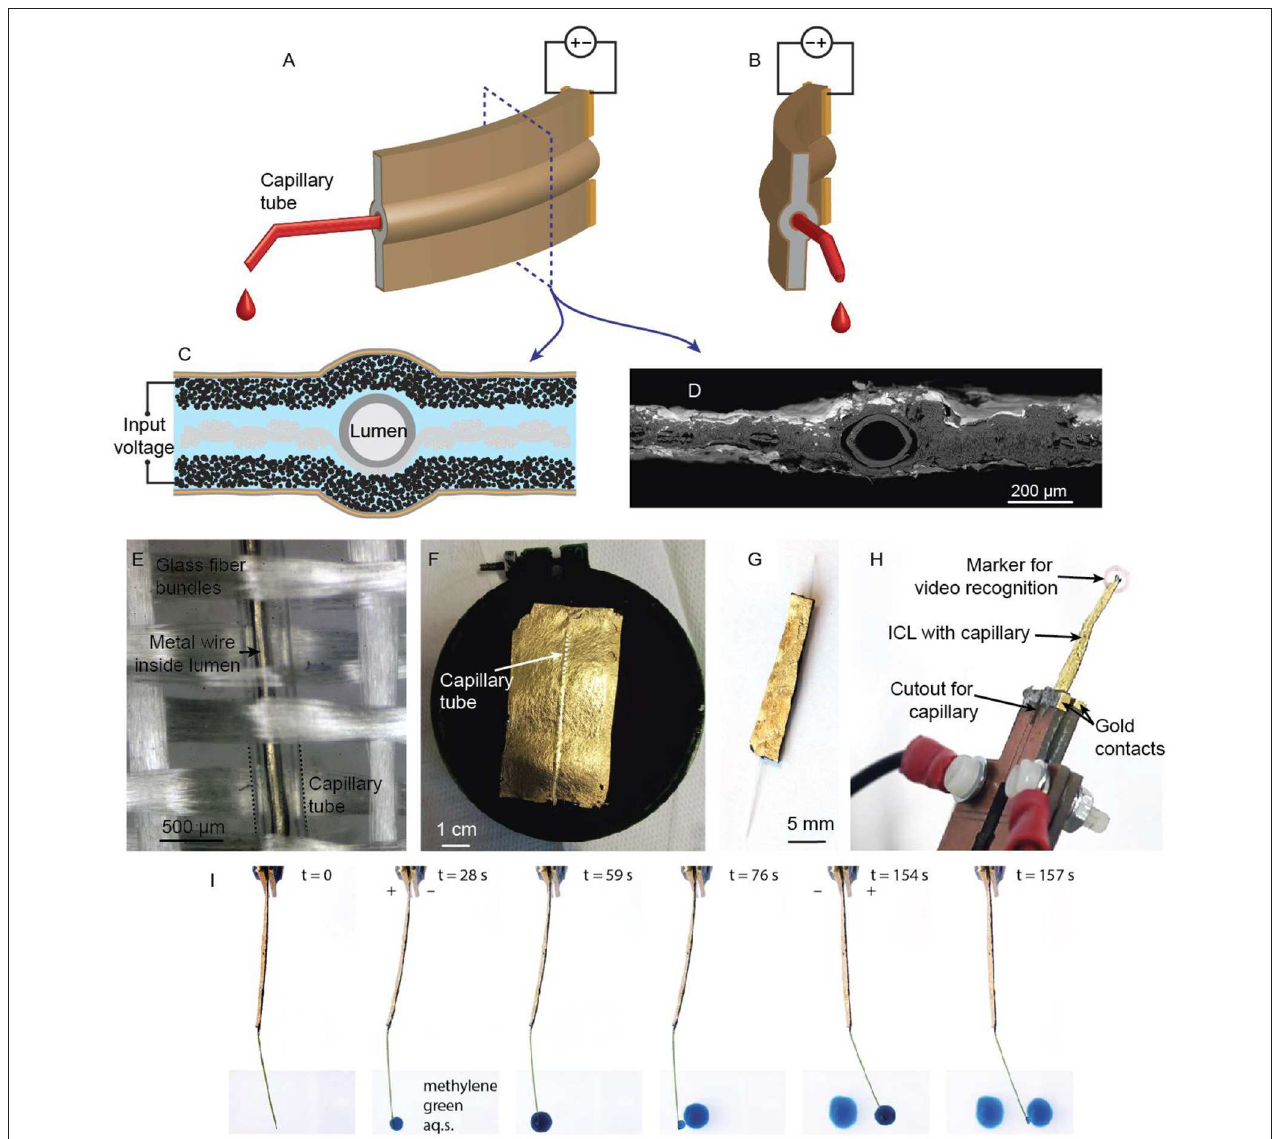
FIGURE 5 | (A,B) the concept of an active pipette for positioning fluids in oppositely polarized states. (C) The cross-section diagram and (D) an SEM micrograph of the mosquito proboscis-inspired ICL-pipette assembly, showing the arrangement of the capillary tube in the center of the laminate. (E) A macro photograph of the glass fiber cloth with an interwoven capillary tube before application of the membrane. (F) The active pipette after application of electroactive layers; the elevated strip indicates the location of the capillary tube. (G) The finished active pipette. (H) The active pipette in its holder, showing the gold contacts and a marker attached for video recognition. (I) Deposition of methylene green dye by an electrically steerable